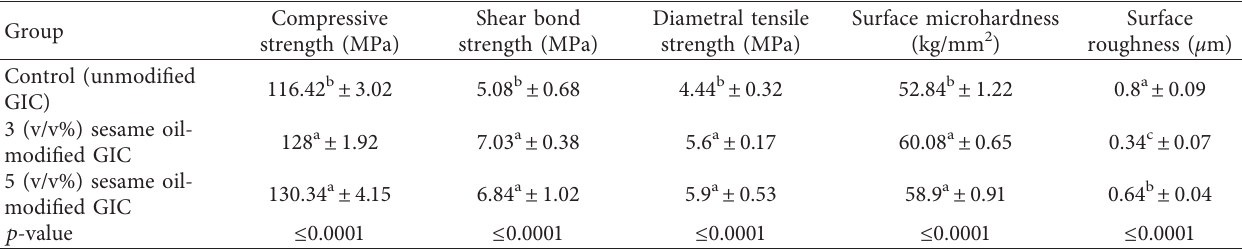
Table 1: Means, standard deviations and Tukey’s analysis of the physical properties of the studied groups. Group